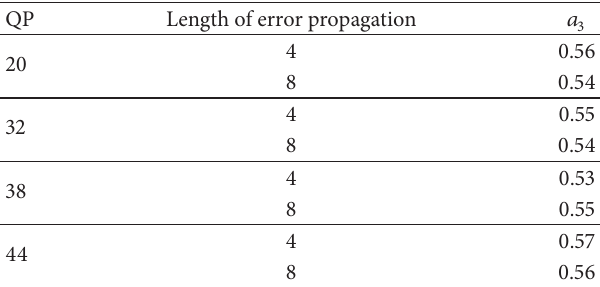
Table 5: Value of 𝑎 3 at the different QPs and